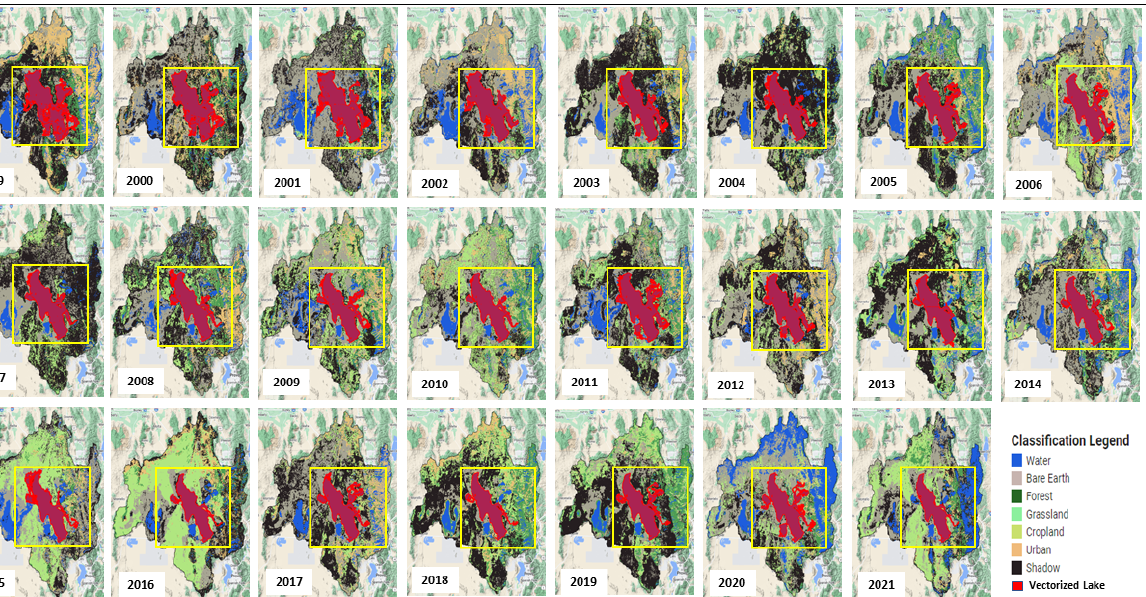
Figure 3. The Great Salt Lake surface water extent change through time. Vectorized lake of interest is in red, while the rest of unconnected pockets of water bodies are in blue. The rest of the features are represented with different colors in the image.